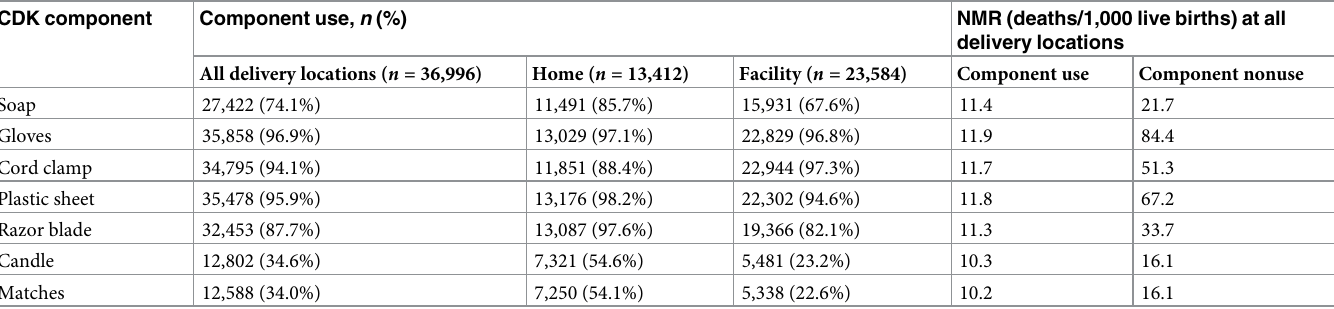
Table 2. CDK use by component.